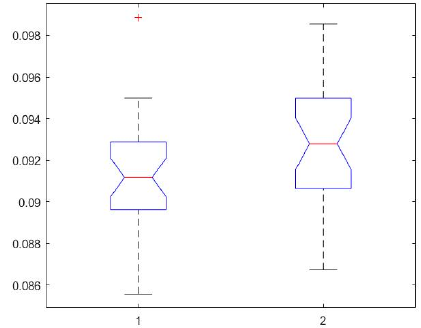
1. MAPE indicator. The result indicates relatively similar MAPE values.